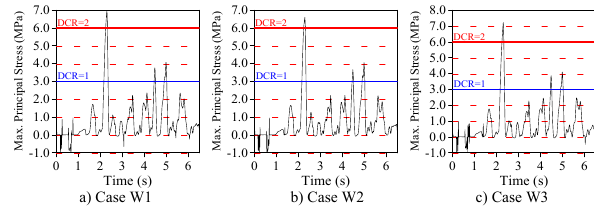
Fig. 19. The time histories of maximum stresses at nodal point 48 of the arch dam for Case W The performance curves at nodal point 48 (Fig. 4) of the arch dam are presented in Fig. 20 for Case W1, W2, and W3. The level of nonlinear response or opening construction joints and/or